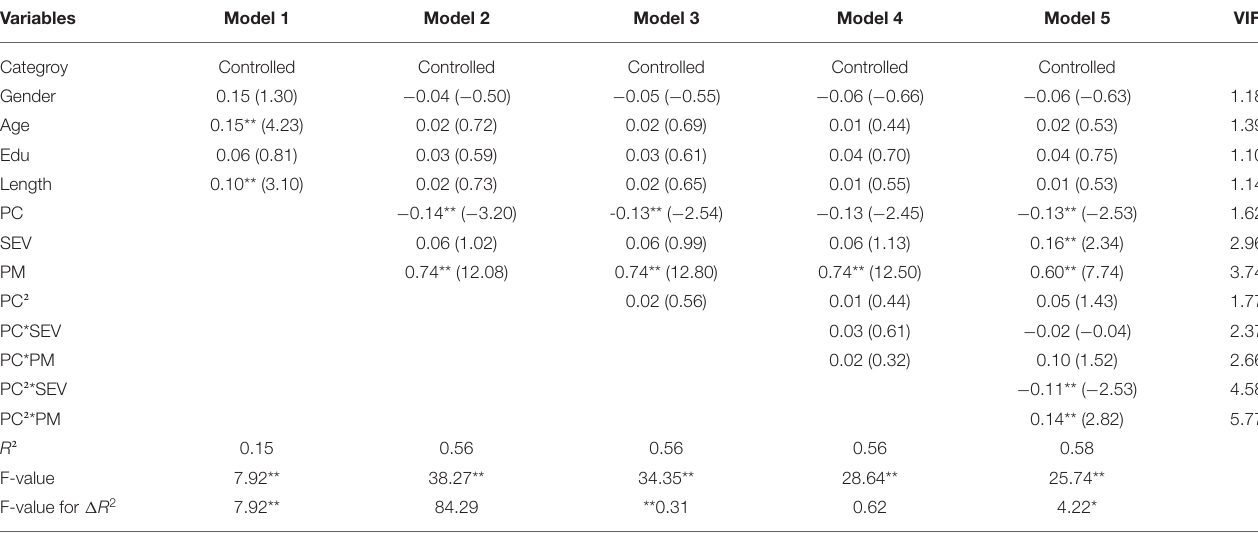
TABLE 3 | Results of hierarchical moderated regression analyses.